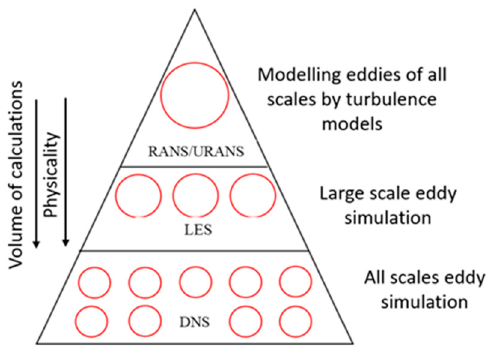
Figure 1. Comparison of different approaches to modeling turbulent flows.